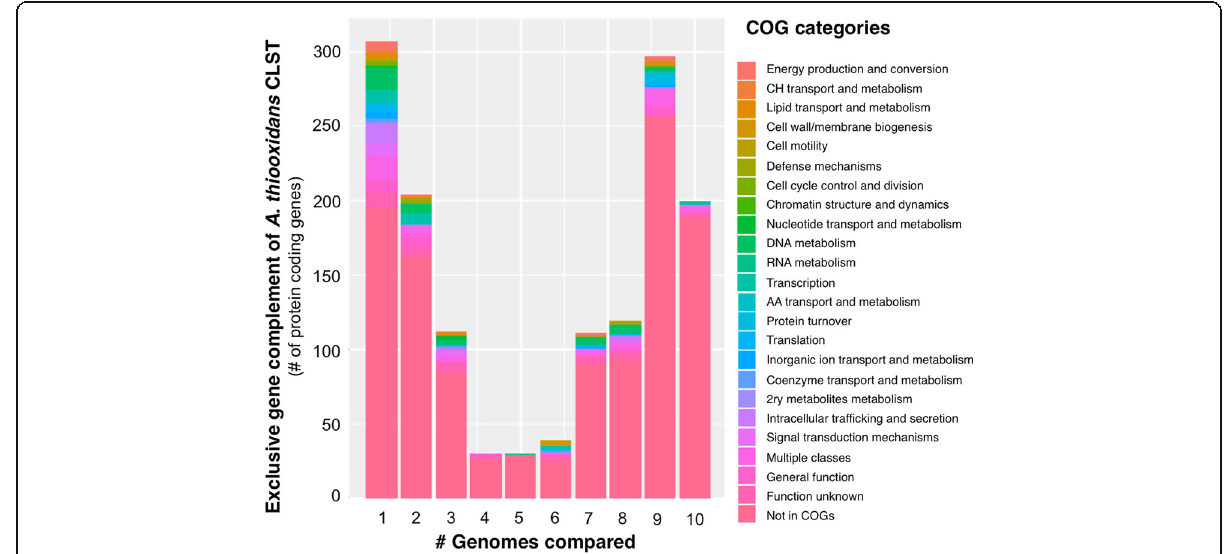
Fig. 3 Exclusive gene complement of A. thiooxidans strain CLST relative to other strains of the species. All possible pairwise comparisons were performed. The number of exclusive genes resulting from the pairwise comparisons between the genomes of CLST and the other A. thiooxidans strains is plotted against the number of genomes compared. Genes were color coded according to their COG predicted function, as indicated in the lateral